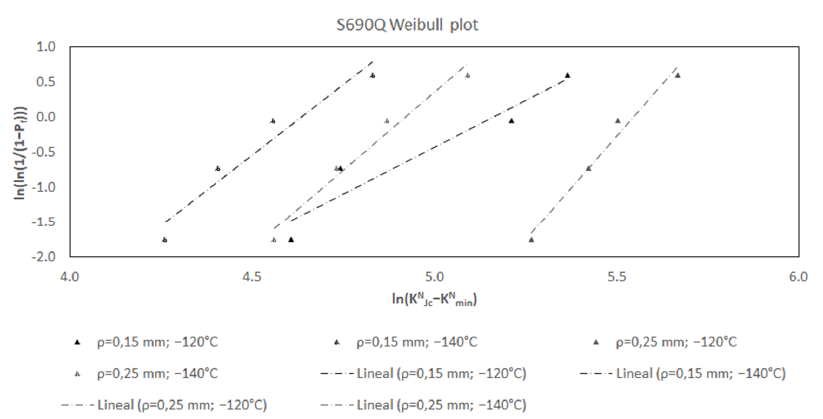
Figure 4. Statistical distribution of K N Jc values determined from the three-parameter Weibull function for steel S690Q.